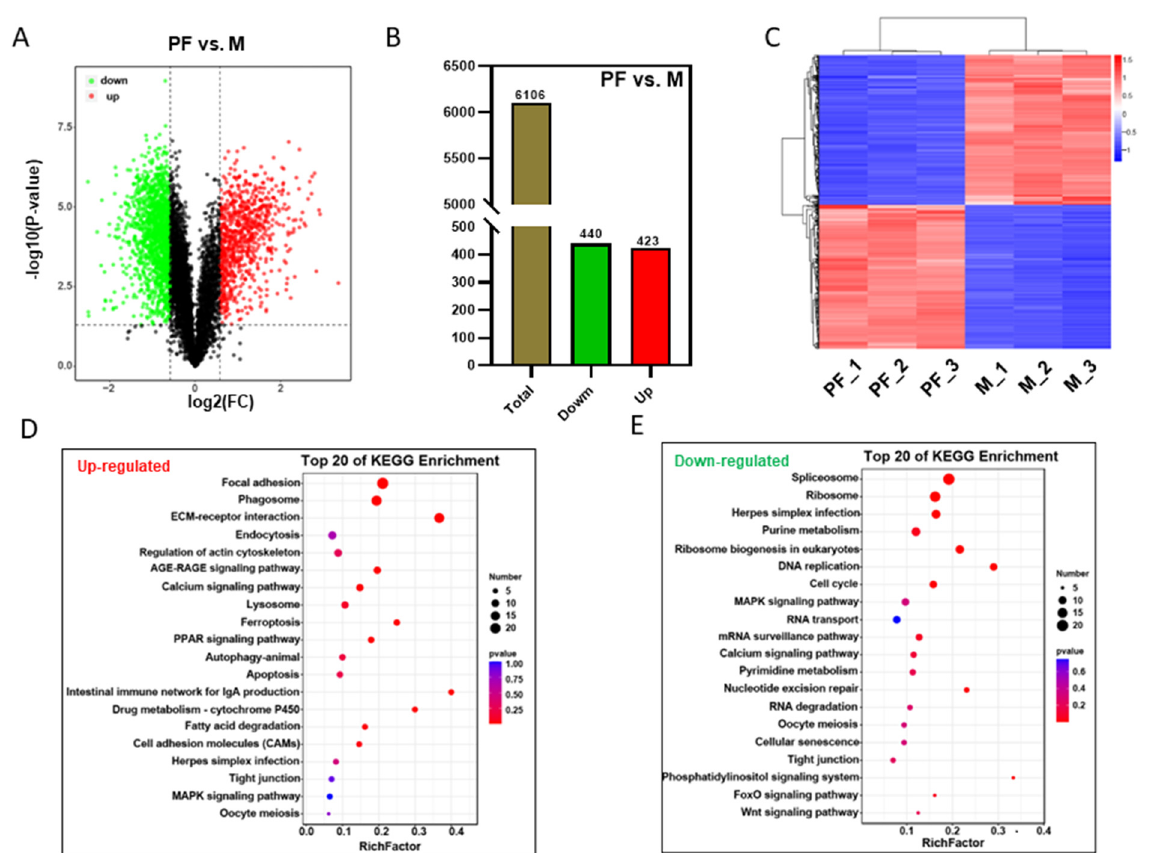
Figure 3. Analysis of differentially abundant proteins analysis between males and pseudo-females. ( A ) The differentially abundant proteins between pseudo-females and males. ( B ) The number of differentially abundant proteins between pseudo-females and males. ( C ) Cluster analysis of differentially abundant proteins between males and pseudo-females. ( D ) Top 20 enriched signaling pathways of upregulated proteins between pseudo-females and males. ( E ) Top 20 enriched signaling pathways of downregulated proteins between pseudo-females and males.